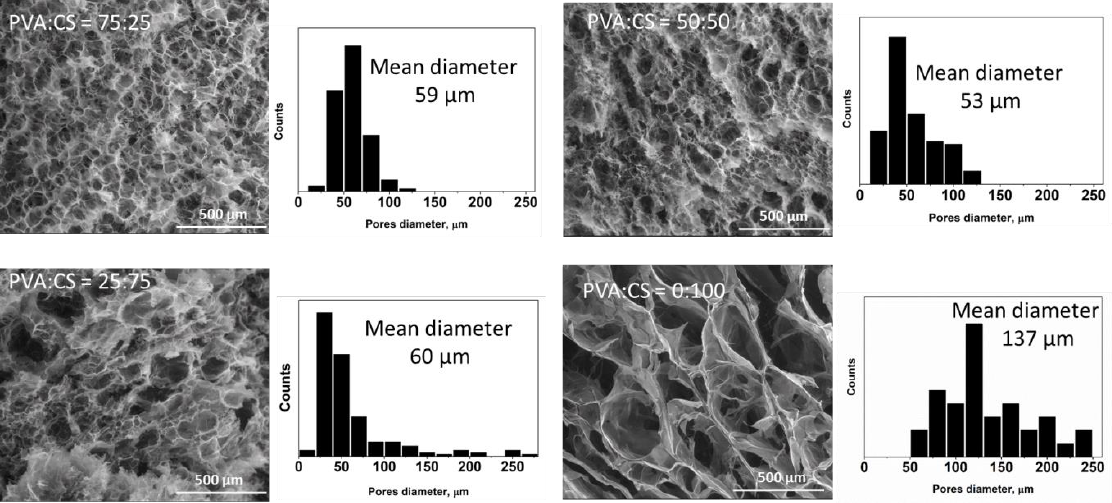
Figure 4. SEM images and the corresponding pore size distribution diagrams for the lyophilized hydrogels with different PVA:CS (wt:wt) ratios obtained with CS:OA = 1:1 (wt:wt) and 7 F-T cycles. In order to verify the composition of the hydrogels after washing (leakage of the non- cross-linked species), the content of CS in purified samples was determined by ninhydrin assay and the results are presented in Table 2. With the decrease of the PVA:CS ratio in the precursors mixture, the CS content deviated from the theoretical values, and this increase was due to the leakage of OA and PVA during the purification. The leakage of the excess of OA was also observed for the hydrogel obtained only from CS and dicarboxylic acid. Table 2. The content of CS in hydrogels with different PVA:CS:OA ratio. CS Content, wt% PVA:CS:OA ( wt:wt:wt ) Theoretical